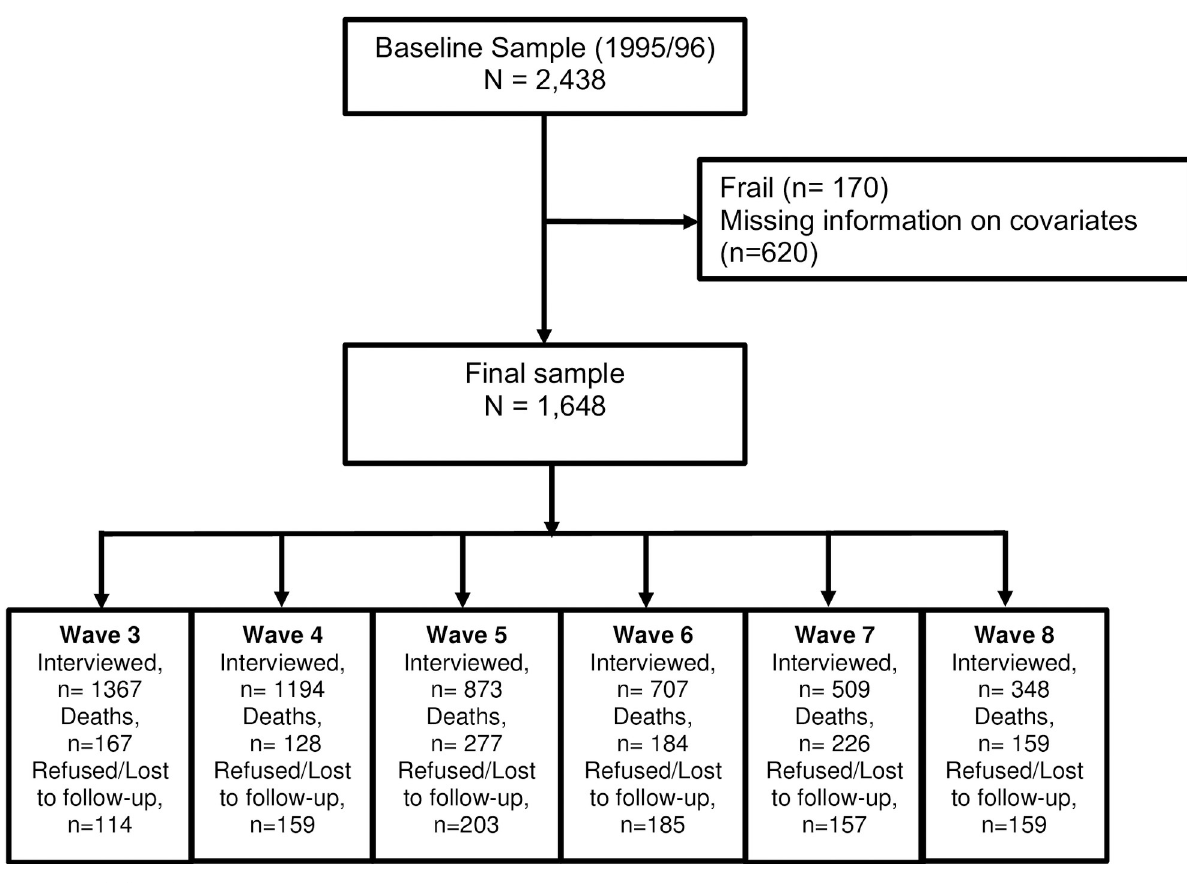
Fig 1. Sample flow